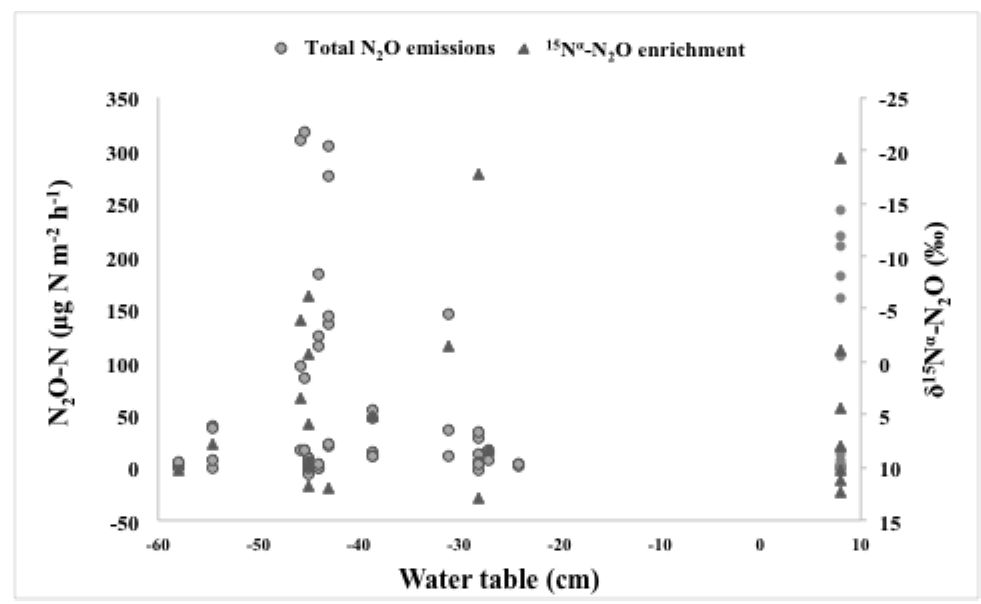
Figure 3. Total N 2 O emissions and δ 15 N α enrichment in N 2 O versus water table. In flooded conditions, fluxes depend on O 2 concentration changing with flooding time. The parabolic trendline of N 2 O emissions is shown (R 2 = 0.08; p <